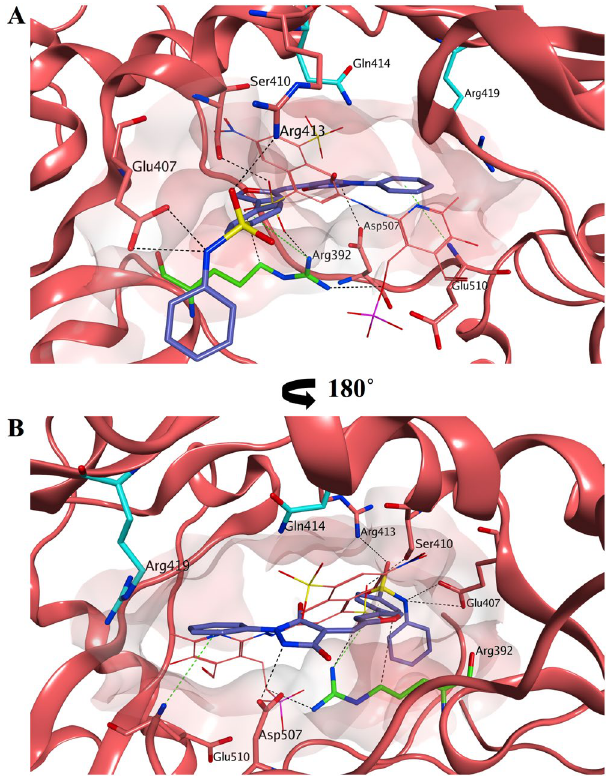
Figure 14. Proposed binding mode for 54 in the human norovirus RdRp. ( A ) Compound 54 (carbon atoms in lilac) is occupying site-B in a different orientation compared to PPNDS (carbon atoms in pink) with its phenyl- benzenesulfonamide portion pointing out from the site-B interacting through its sulphonamide group with Glu407 and Arg413 and through an arene-cation interaction between Arg392 and the benzene ring. ( B ) The binding site rotated by 180° shows the phenyl-pyrazolidine portion of 54 occupying the area where PPNDS places its naphthylazo portion, the core area of site-B, making interactions with the surrounding amino acids (Asp507, Glu510). No interactions are present between 54 and the two residues, Glu414 and Arg419. The binding site area is represented as molecular surface. Human norovirus RdRp is represented as salmon